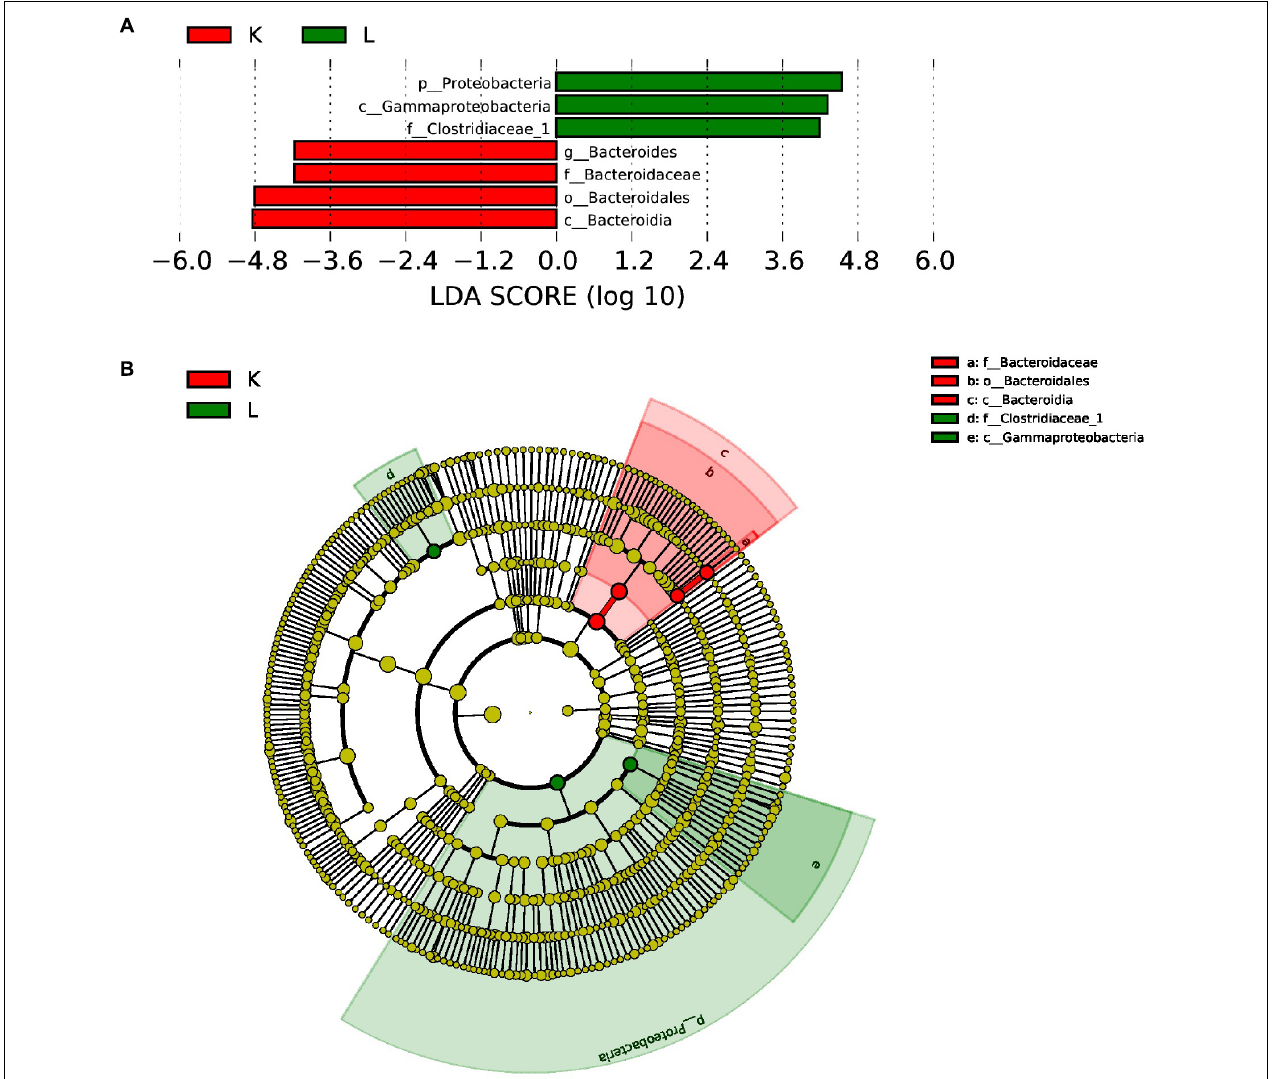
FIGURE 8 | LEfSe (LDA Effect Size) analysis (A) and the cladogram (B) in European mouflon. The different colors represent the different groups. The histogram (A) shows the biomarkers with statistical differences between groups and the lengths of the bars indicate the influential degree of the species. The cladogram (B) demonstrates the classification of taxa at five levels, and the red and green circles indicate the differences in relative abundance. Non-significant differences are expressed by the yellow circles. K, low-altitude mouflon; L, high-altitude mouflon.